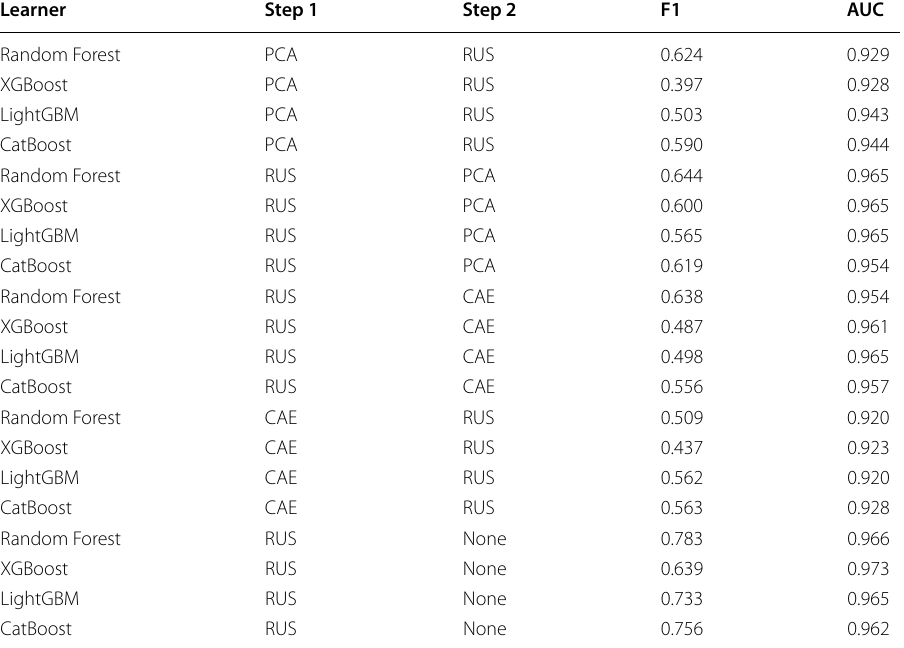
Table 5 Performance scores for RUS (1:10 ratio)